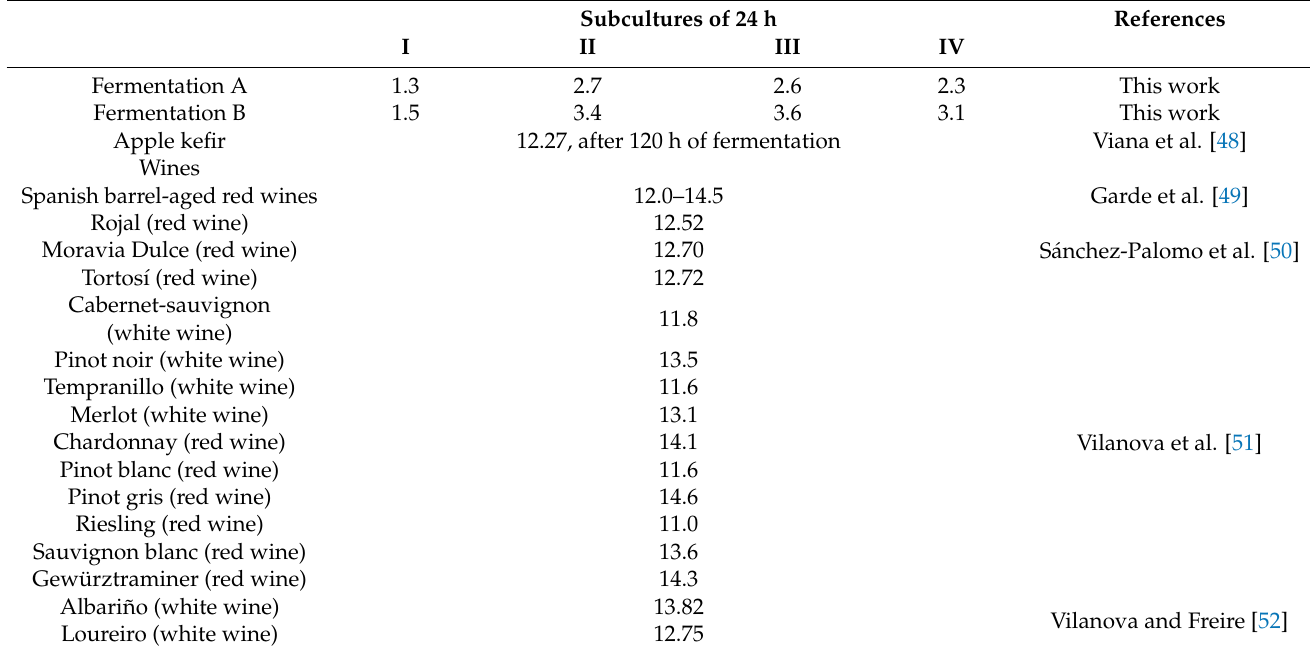
Table 5. Comparisons of the Mean Alcoholic Content (%, v / v ) in the Fermented Samples from the Four Subcultures of Fed-Batch Fermentations A and B with Other Fermented Beverages. The Soluble Solids Content of the Table Grape Juice was 15.6 ± 0.02 ◦